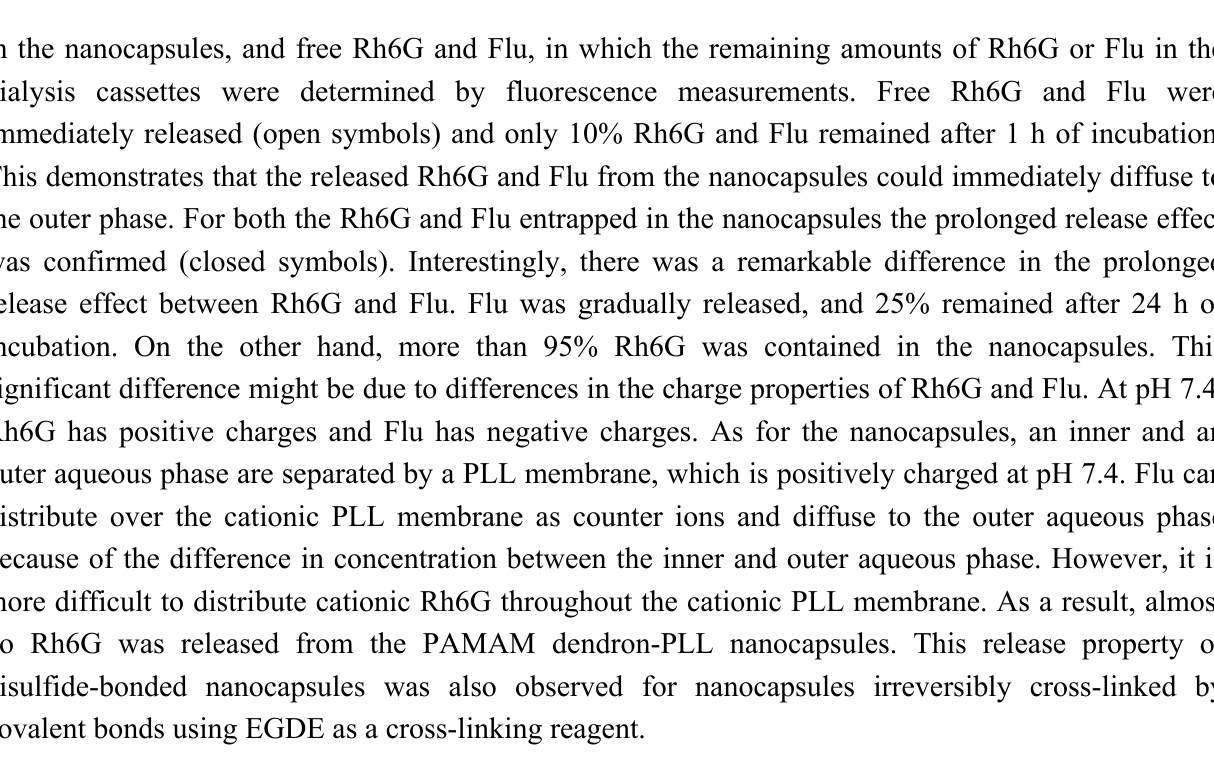
Figure 5. Time course of the remaining amounts of rhodamine 6G (red) and fluorescein (green) in a dialysis